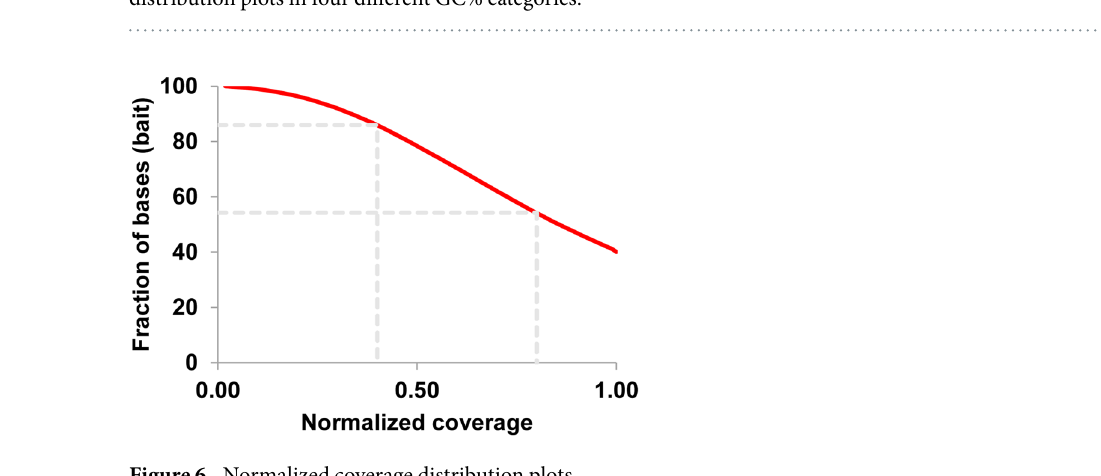
Figure 6. Normalized coverage distribution